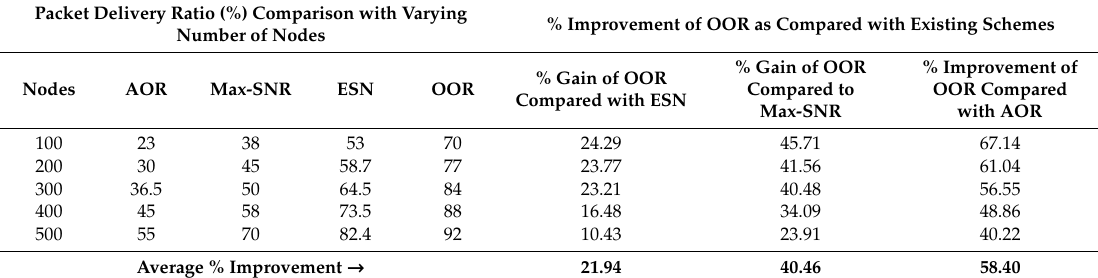
Table 2. Descriptive observations of OOR performance in terms of packet delivery ratio.